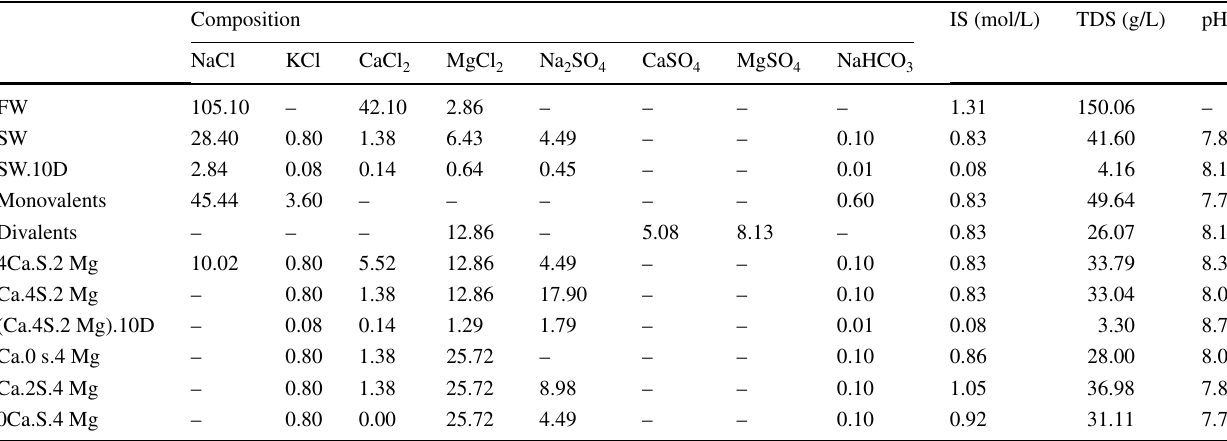
Table 2 Composition of used solutions